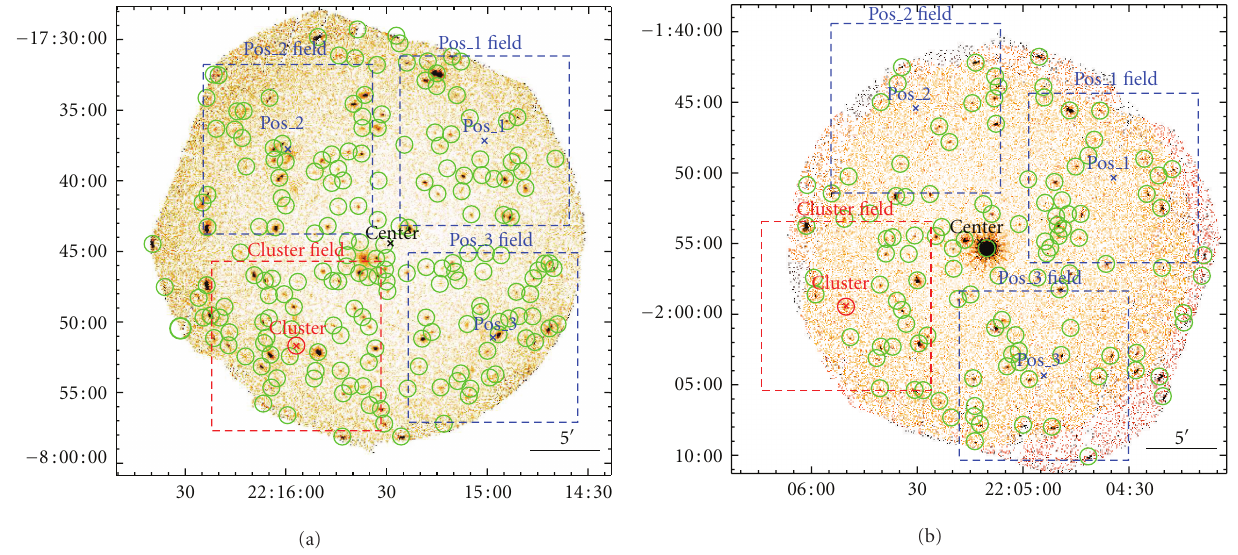
Figure 1: Examples of the extraction and stacking process for the 82.2 ksec field of cluster XDCP J2215.9 − 1751 (C09) in the left panel and the 24.9 ksec observation of the system XDCP J2205.8 − 0159 (C12) in the right panel. The cluster positions and the 12 (cid:3) × 12 (cid:3) region around them are indicated in red. The three control fields at equivalent o ff -axis angles from the center position (black) are marked in blue. Green circles mark the positions of all detected soft-band X-ray point sources in the fields.